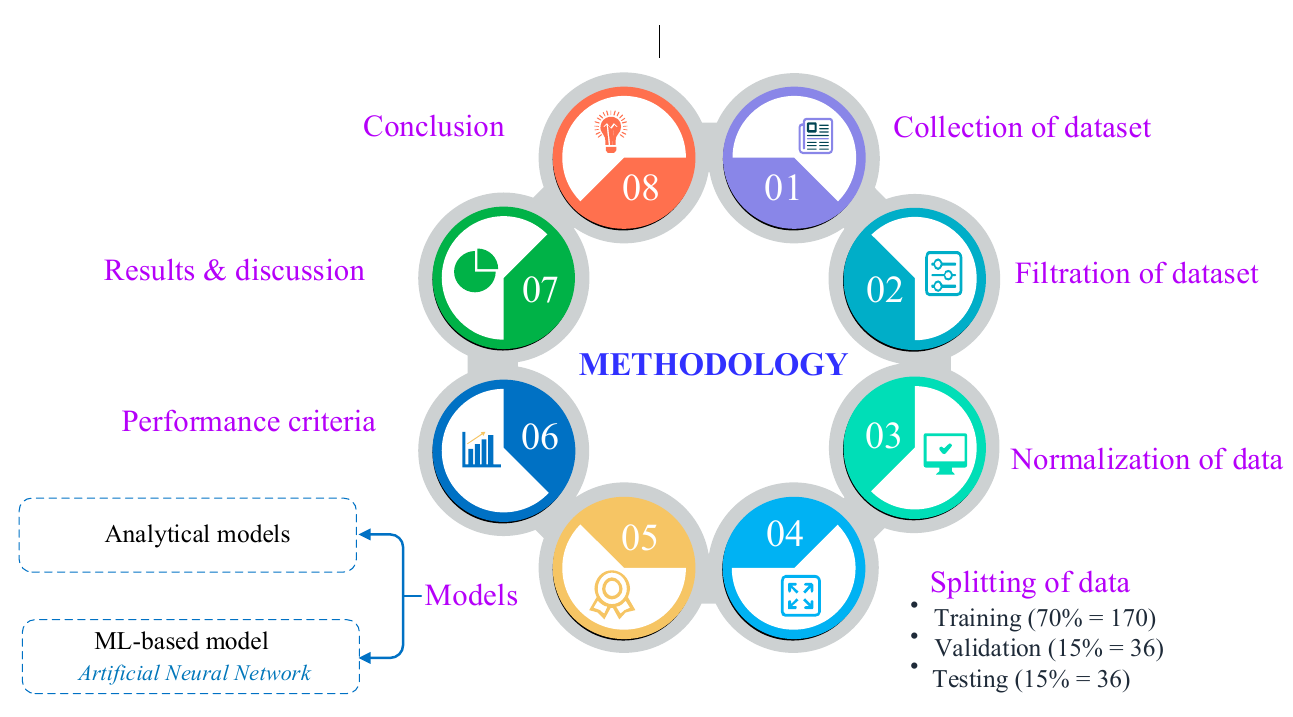
Figure 2. Methodology diagram.